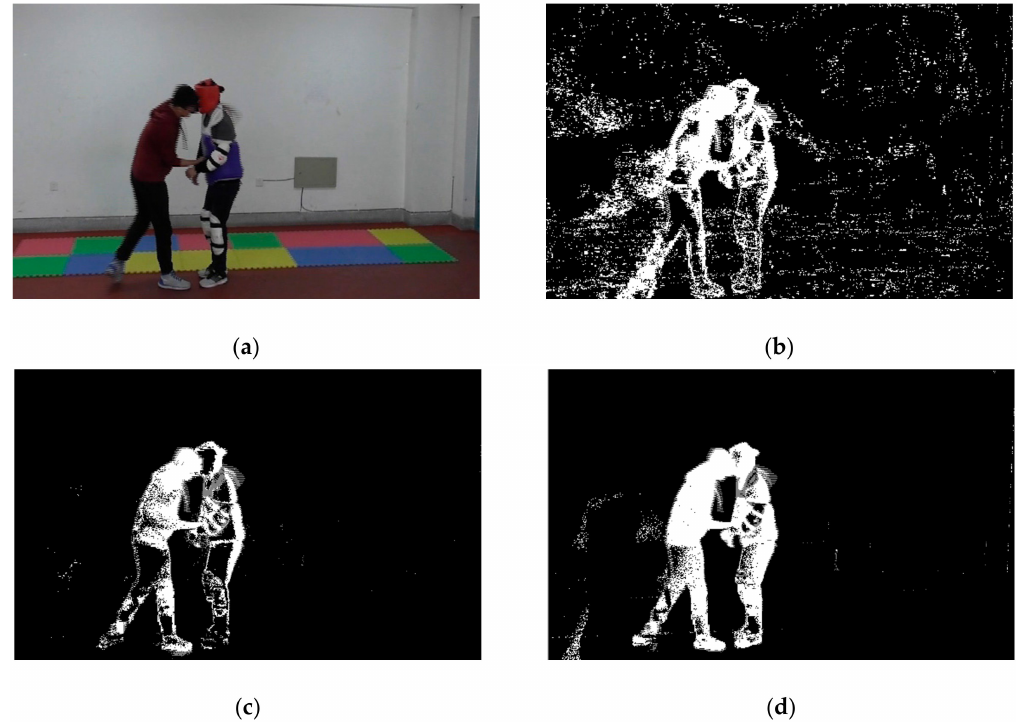
Figure 4. Foreground target extraction with di ff erent algorithms: ( a ) original image; ( b ) Geometric Multigrid (GMG) detection; ( c ) Mixture of Gaussians (MOG2) detection; and ( d ) K-Nearest Neighbor (KNN)